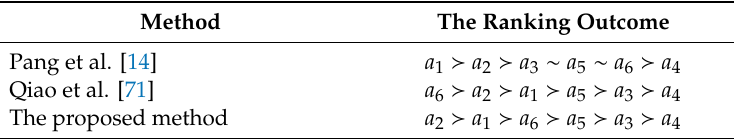
Table 5. The list of ranking